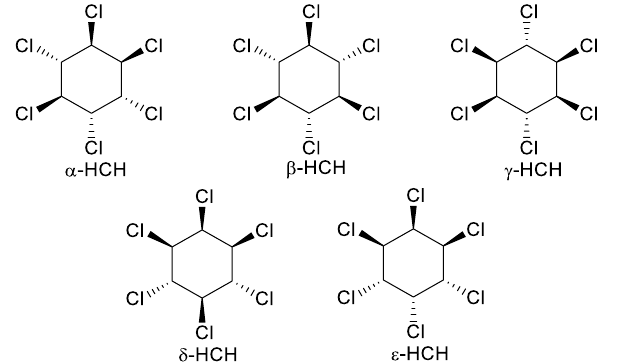
Figure 1. Major HCH